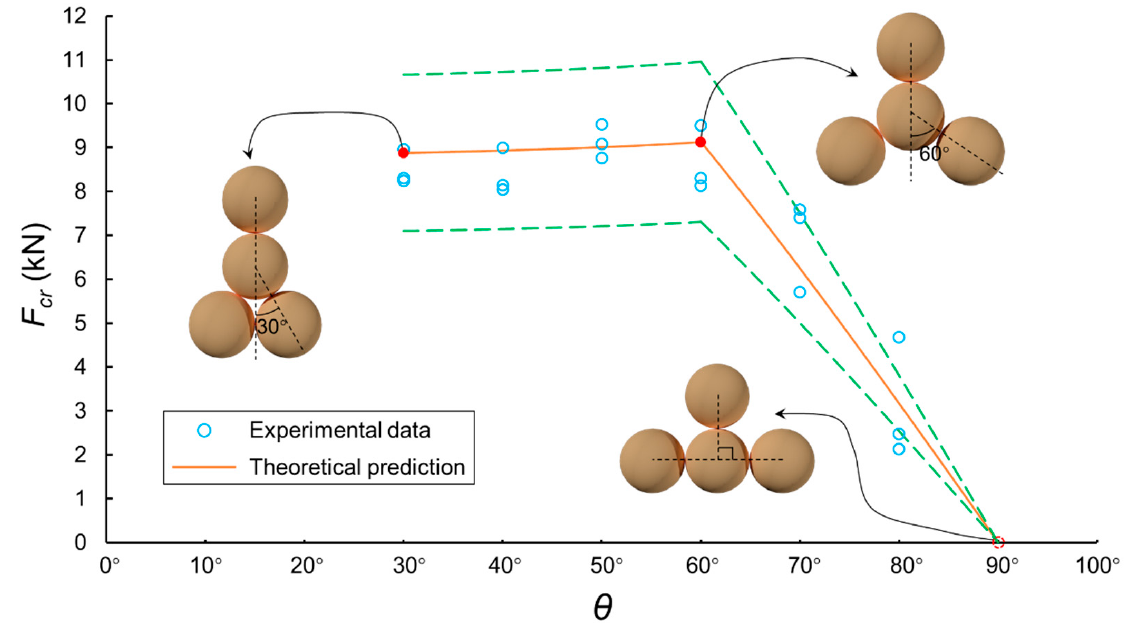
Figure 10. The relationship between F cr and θ both theoretically and experimentally. The green dashed lines indicate a 20% range.